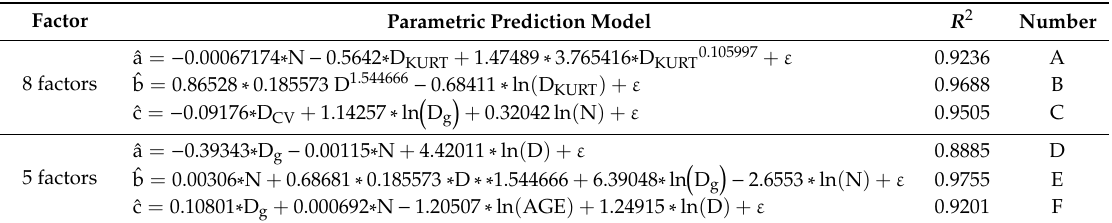
Table 6. Parametric prediction models and their prediction e ff ects.